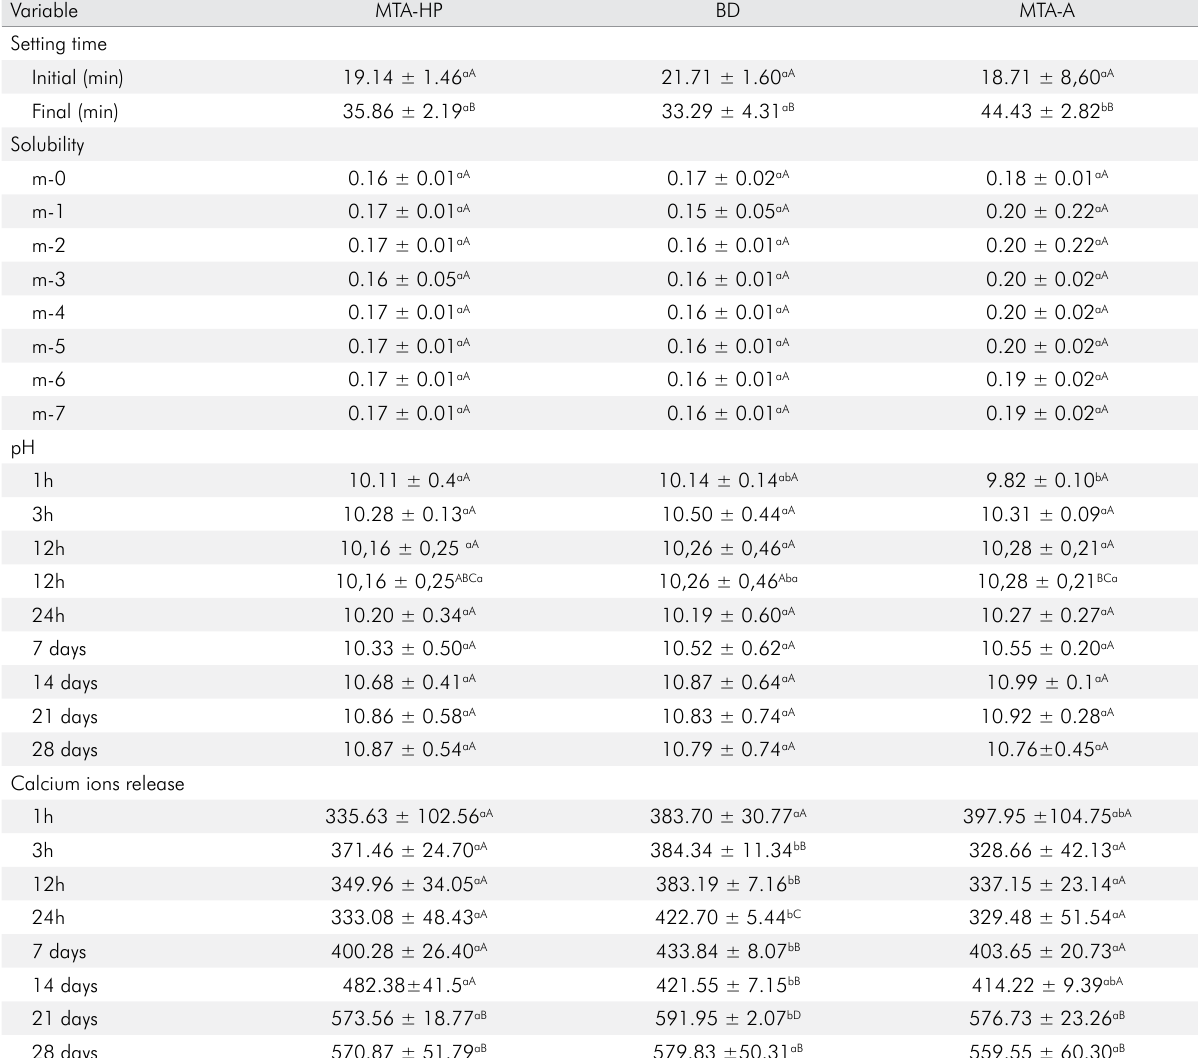
*Different lowercase letters in each row indicate significant difference amongst experimental groups (p < 0.05). Different capital letters in each column indicate significant differences among experimental periods (p <